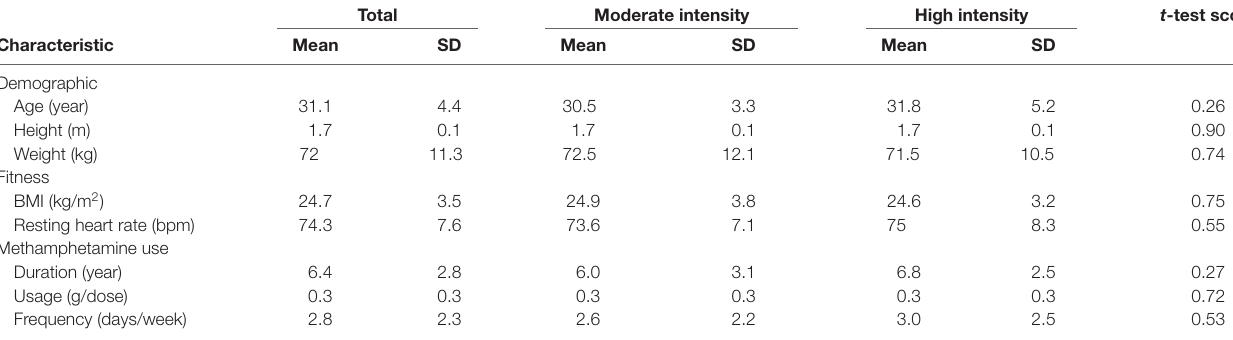
TABLE 1 | Demographic and fitness characteristics of all participants by exercise intensity.